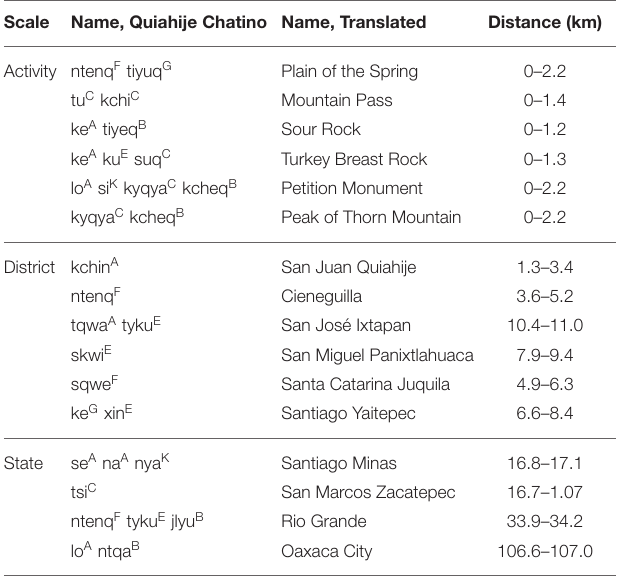
TABLE 4 | Walking interview targets: scale, names, and distance range. Scale Name, Quiahije Chatino Name,